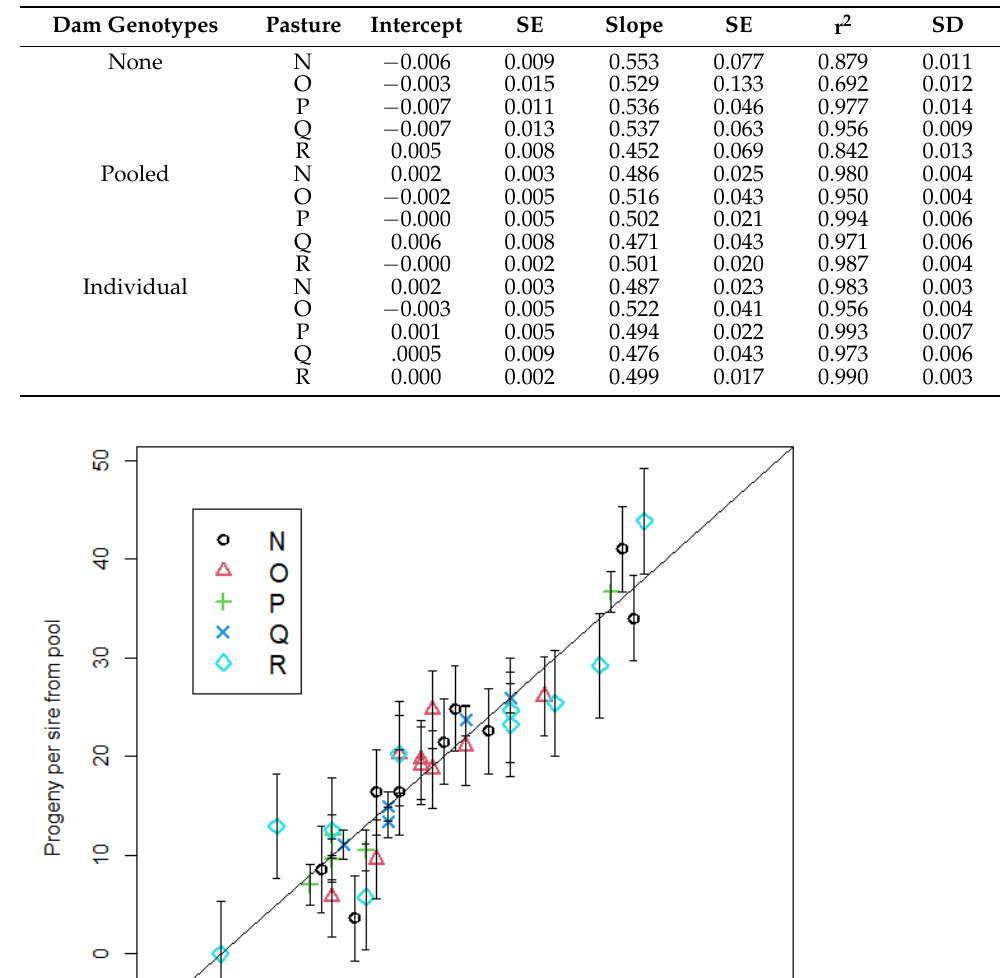
Table 6. Intercept, slope and r2 from regressing pooling estimates of sire progeny proportions on known proportions 100 simulated replicates using 14,190 autosomal.